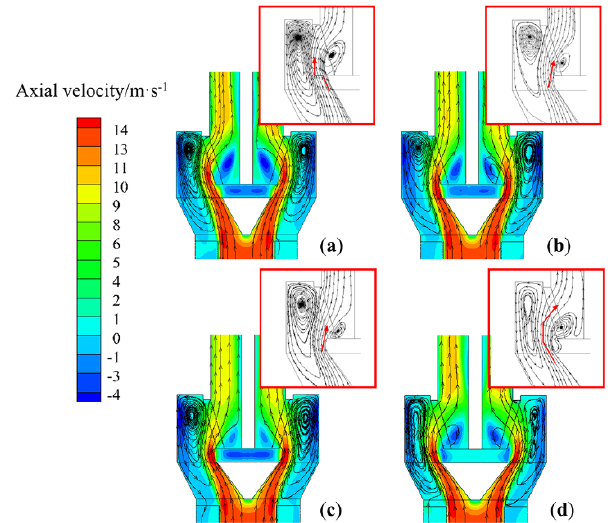
Figure 24. Effect of the diameter of the diversion cone on the axial velocity and gas movement (T-D (1-0.7) , x = 0): ( a ) d = 154 mm, ( b ) d = 173.3 mm, ( c ) d = 192.5 mm, and ( d ) d = 211.7 mm.